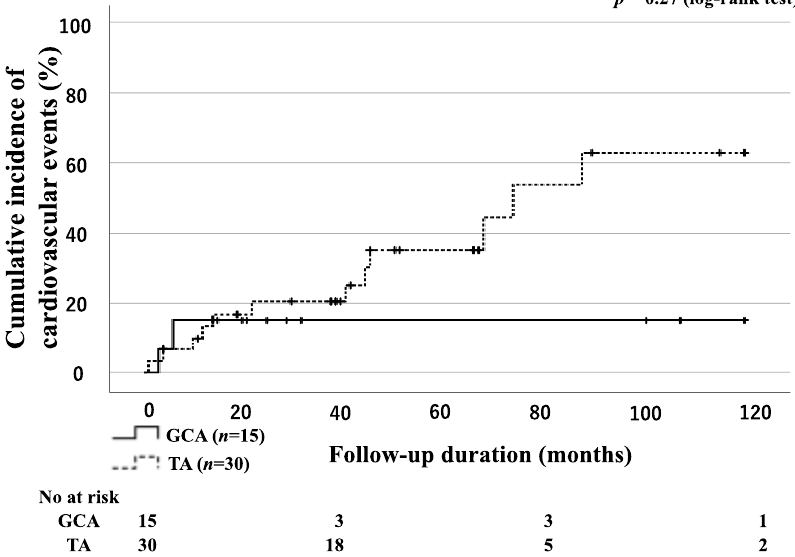
Figure 4. Cumulative incidence curves of cardiovascular events in patients with GCA and TA. Kaplan–Meier curves show the cumulative incidence of cardiovascular events in patients with GCA ( n = 15) and TA ( n = 30). No significant differences were observed between the GCA and TA groups. The starting point (0 months) was the date when observation began.